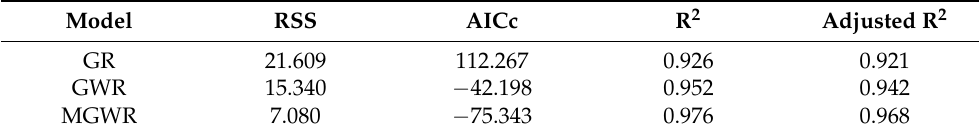
Table 6. Comparison of indicators of three